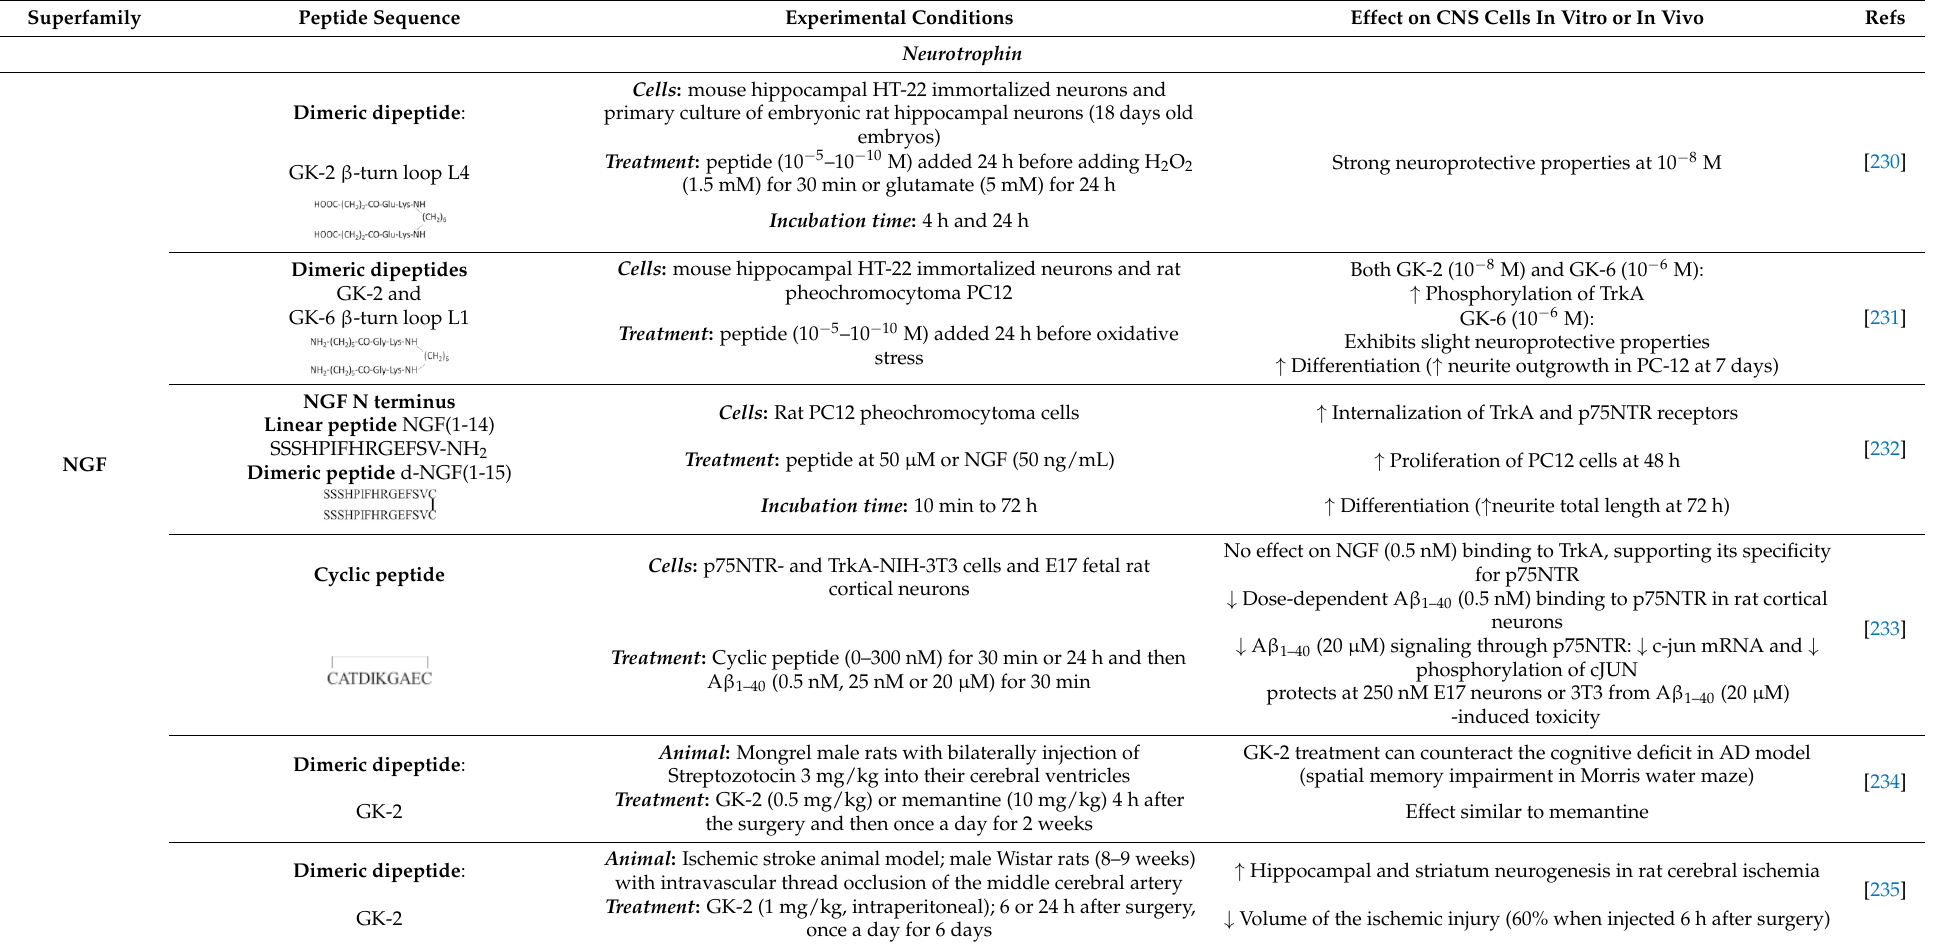
Table 2. Effect of the peptides derived from growth factors on CNS cells and their potential effect on Alzheimer’s disease.